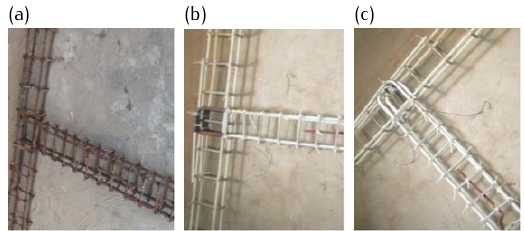
Figure 4. (a)Skeletonofbeam-columnjointwithsteelreinforcement; (b) Skeleton of beam-column joint-GFRP reinforcement with steel bend coupler at the joint; (c) Skeleton of beam- column joint-GFRP reinforcement with FRP bend coupler at the joint.